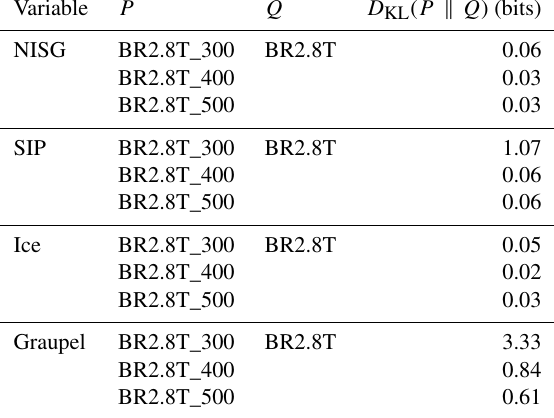
Table C1. The Kullback–Leibler divergence, D KL ( P (cid:107) Q ), be- tween two probability distributions P and Q from 14:14 to measured probability distribution against the reference probability distribution Q (BR2.8T). Each distribution consist of ∼ 10800 grid points separated into 24bins over the cross section in Fig.